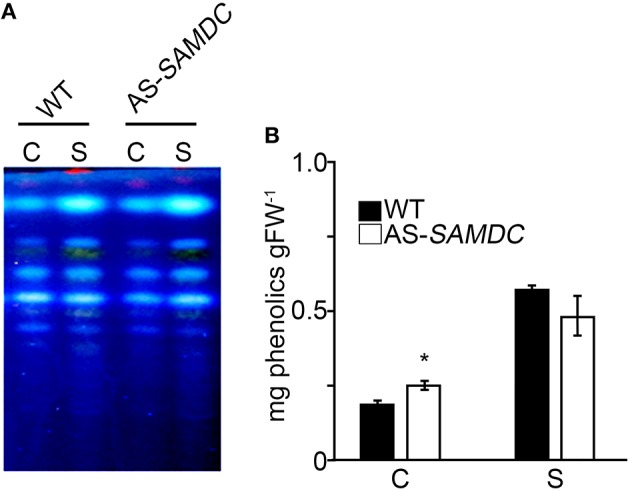
Qualitative and quantitative analysis of total phenolics from WT and AS-SAMDC transgenics. (A) TLC analysis and (B) Quantification of total phenolics from plants 24 h post-treatment with 100 mM NaCl. Data are means ± SE of three biological replicates. Asterisk indicate significant difference of mean values of AS-SAMDC from WT (Student's t-test; P < 0.05).